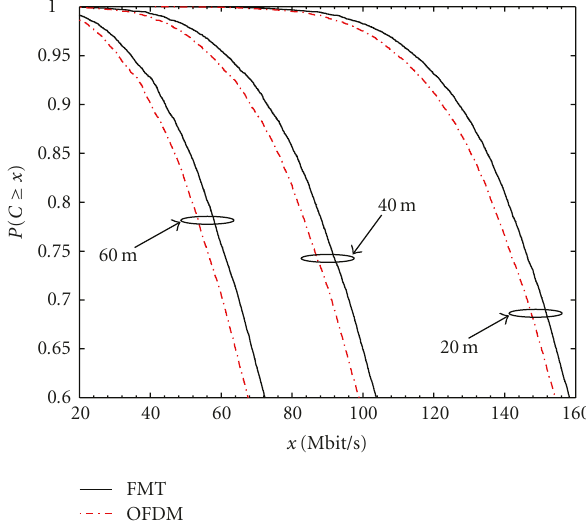
Figure 14: SIR versus the normalized delay spread γ for orthogonal pulse (solid lines) with M 0 = 4, N 0 = 5, and L f = N .